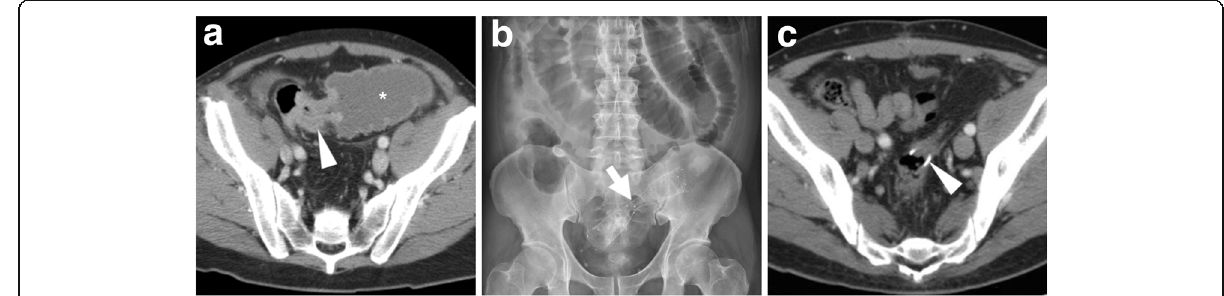
Fig. 8 Delayed relief of LBO during bridge-to-surgery stenting of CRC. Initial CT ( a ) shows luminal dilatation (*) above a stricturing tumour of the sigmoid colon (arrowhead, note shouldering). Early radiograph ( b ) shows persistent colonic dilatation despite correct placement of the SEMS (thick arrow) at the site of CRC. The patient experienced slow clinical and radiographic improvement and had neoadjuvant chemotherapy followed by resection of pT3N2 cancer with primary anastomosis. Note suture on early postoperative CT ( c ) performed to exclude anastomotic